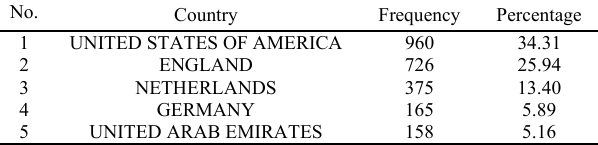
Table 1. Distribution of output of top 5 countries in nanomedicine papers